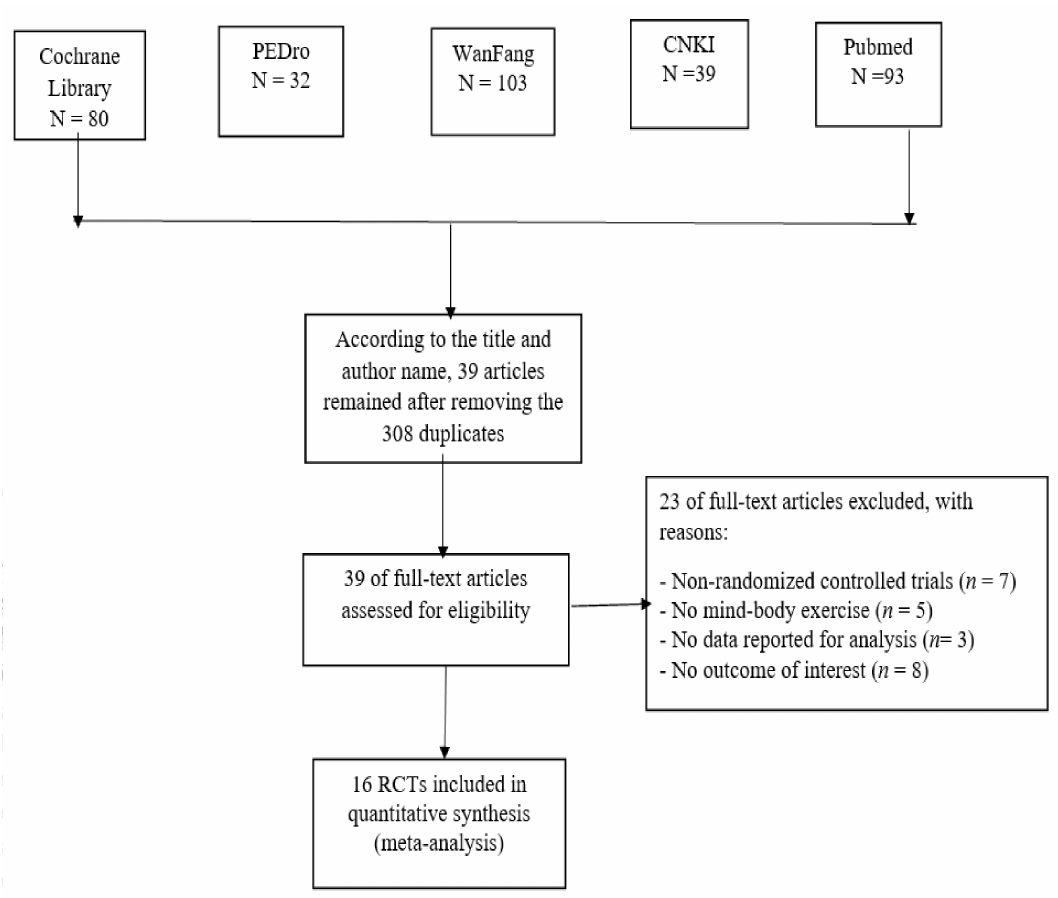
Figure 1. Flowchart showing the retrieval of studies for review (PEDro = Physiotherapy Evidence Database; CNKI = Chinese National Knowledge Information